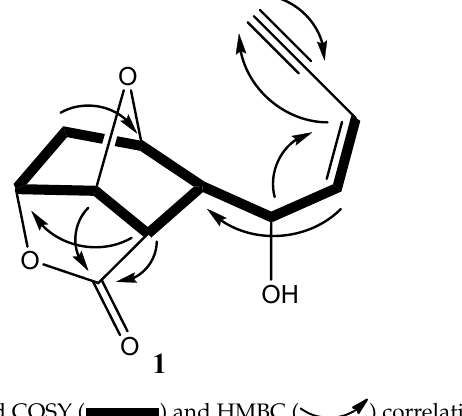
Figure 2. Selected COSY ( ) and HMBC ( ) correlations of 1.